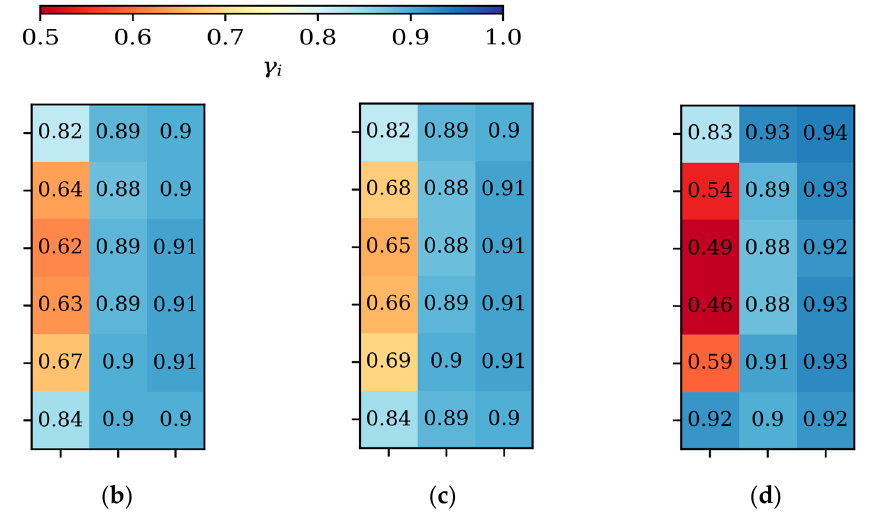
Figure 10. The influence of sampling resolution on uniformity index: ( a ) n r = 20, n θ = 120; ( b ) n r = 5, n θ = 8; ( c ) n r = 5, n θ = 4; ( d ) n r = 2, n θ = 4 ( v w = 7 m/s; β w = 0°).